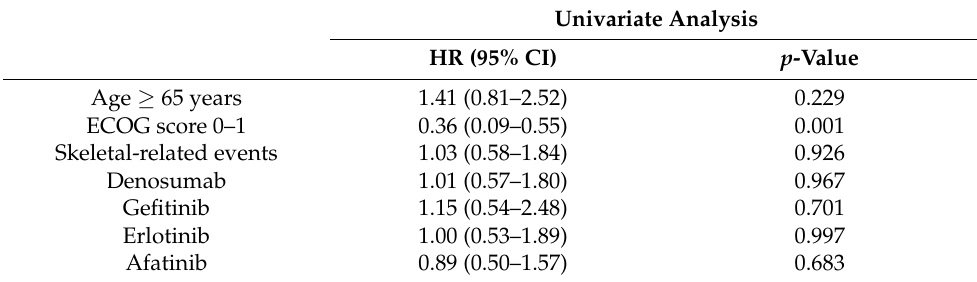
Figure 2. Overall survival (OS) in patients with lung adenocarcinoma and bone metastasis. ( A ) OS in relation to ECOG score, ( B ) OS in relation to denosumab treatment, ( C – E ) OS in relation to first-line EGFR-TKIs. Abbreviations: OS, overall survival; ECOG, Eastern Cooperative Oncology Group. Table 3. Univariate analysis for overall survival.